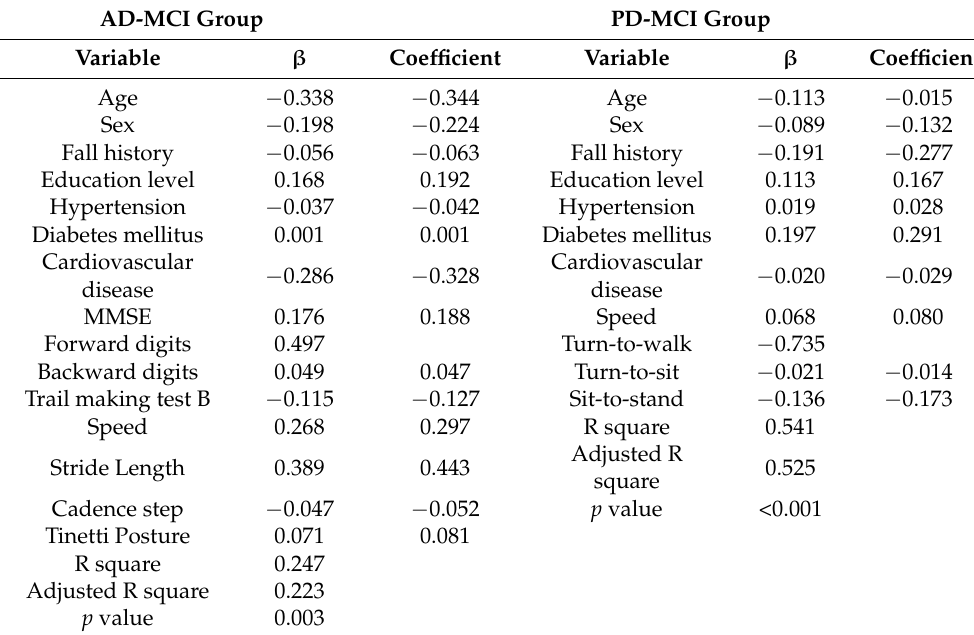
Table 4. Summary of linear regression analyses in the AD-MCI and PD-MCI